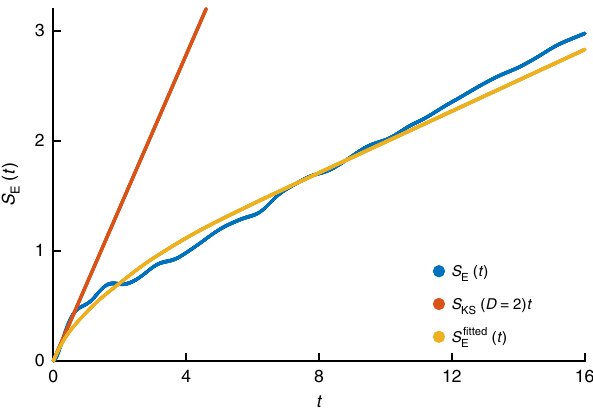
Fig. 5 Entanglement entropy and Kolmogorov – Sinai entropy. The gradient of the entanglement entropy is determined by the Kolmogorov – Sinai entropy. The Kolmogorov – Sinai entropy at D = 2 accurately predicts the gradient of the entanglement entropy at t = 0 (orange). Substituting fi tted forms for the Lyapunov spectrum and saturation entanglement into Eq. (4) gives a zero-parameter fi t to the entanglement entropy (yellow). This fi ts may both be compared with the time evolution of S E ( t ) found using iTEBD at D = 100